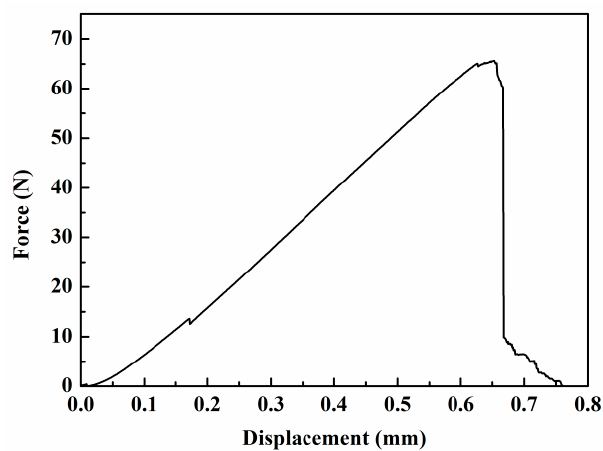
Figure 8. Typical experimental load-displacement curve of the fiber bundles, presenting simultaneous fracture behaviors.